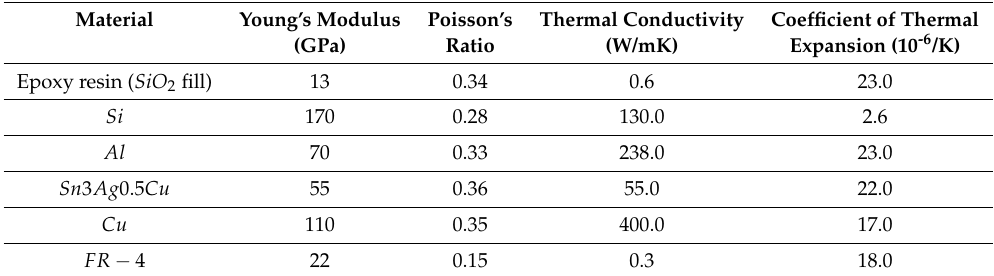
Figure 11. ( a – c ) X-ray images and ( d ) a photograph of the MOSFET used in the interleaved boost converter together with ( e ) the temperature distribution of the constructed 2-D FEM model under an arbitrary load. Table 4. Properties of the materials used in the 2-D FEM MOSFET model of Figure 11 extracted from CES